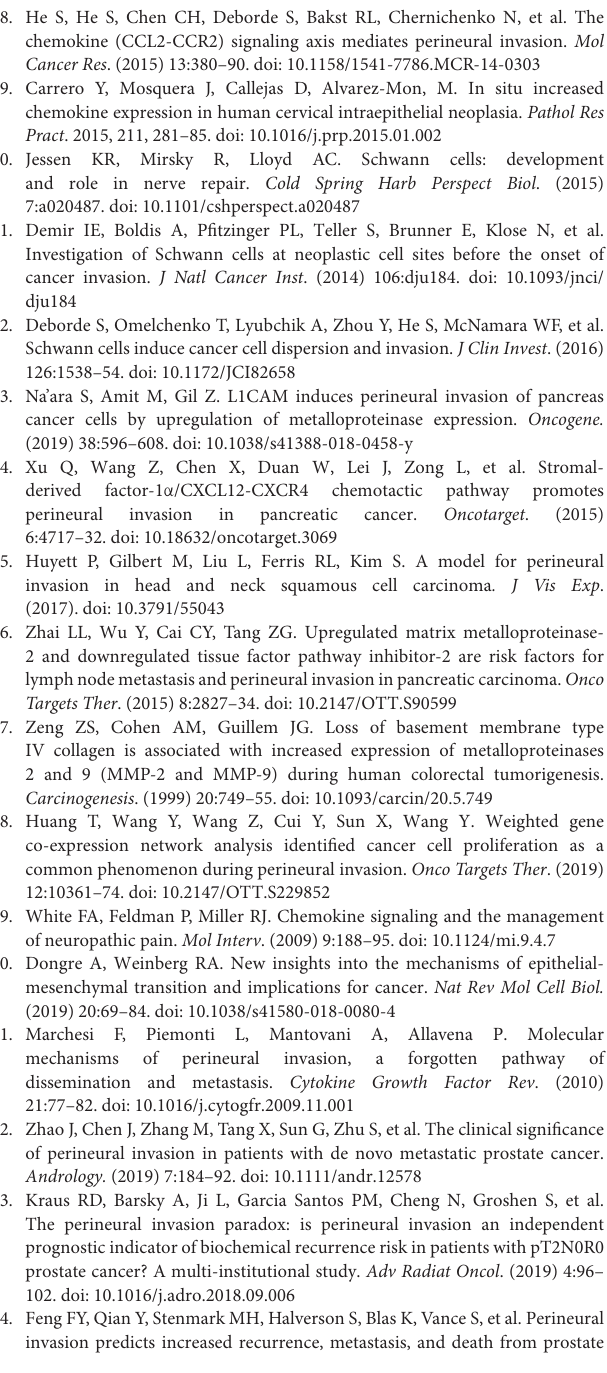
Supplementary Figure 4 | The expression of CCL2/CCR2 and its effect on migration of cancer cells. (A) CCL2 concentration in the supernatant measured by ELISA (ns, not significant, and ∗∗ P < 0.01 compared to the DRG medium group). (B) Increased CCR2 expression in HeLa and ME-180 cells after co-cultivation with SCs. (C,D) Representative images of wound healing assays, 24h after the scratch. The right image shows the statistical results. ∗ P < 0.05 (100 × magnification, scale bar, 100 µ